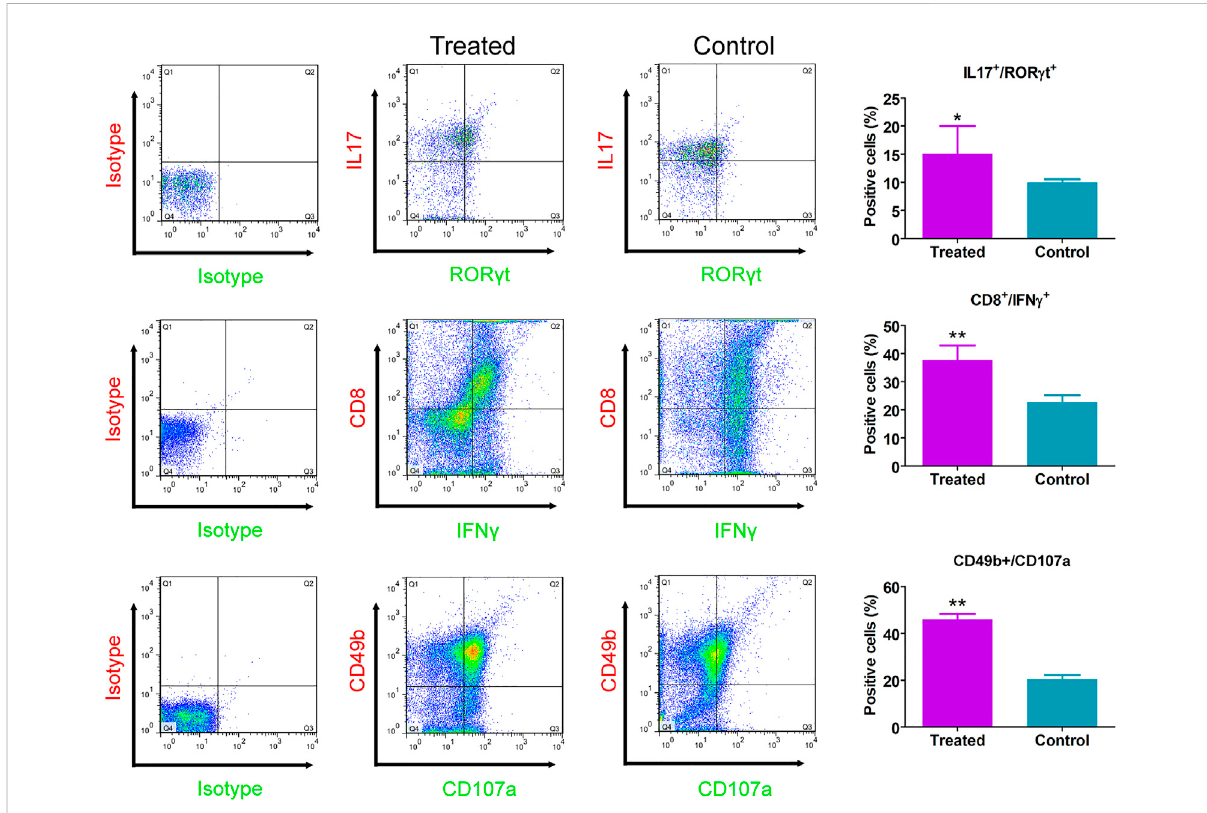
FIGURE 3 Flow cytometry analysis. Relative to the control group, proportion of IL17 + /ROR γ t + , CD8 + /IFN γ + , and CD49b + /CD107a + cells in the peripheral blood of mice in the CHMACS-treated group was signi fi cantly higher. ** p < 0.01 vs. control; * p < 0.05 vs. control; n = 6; t